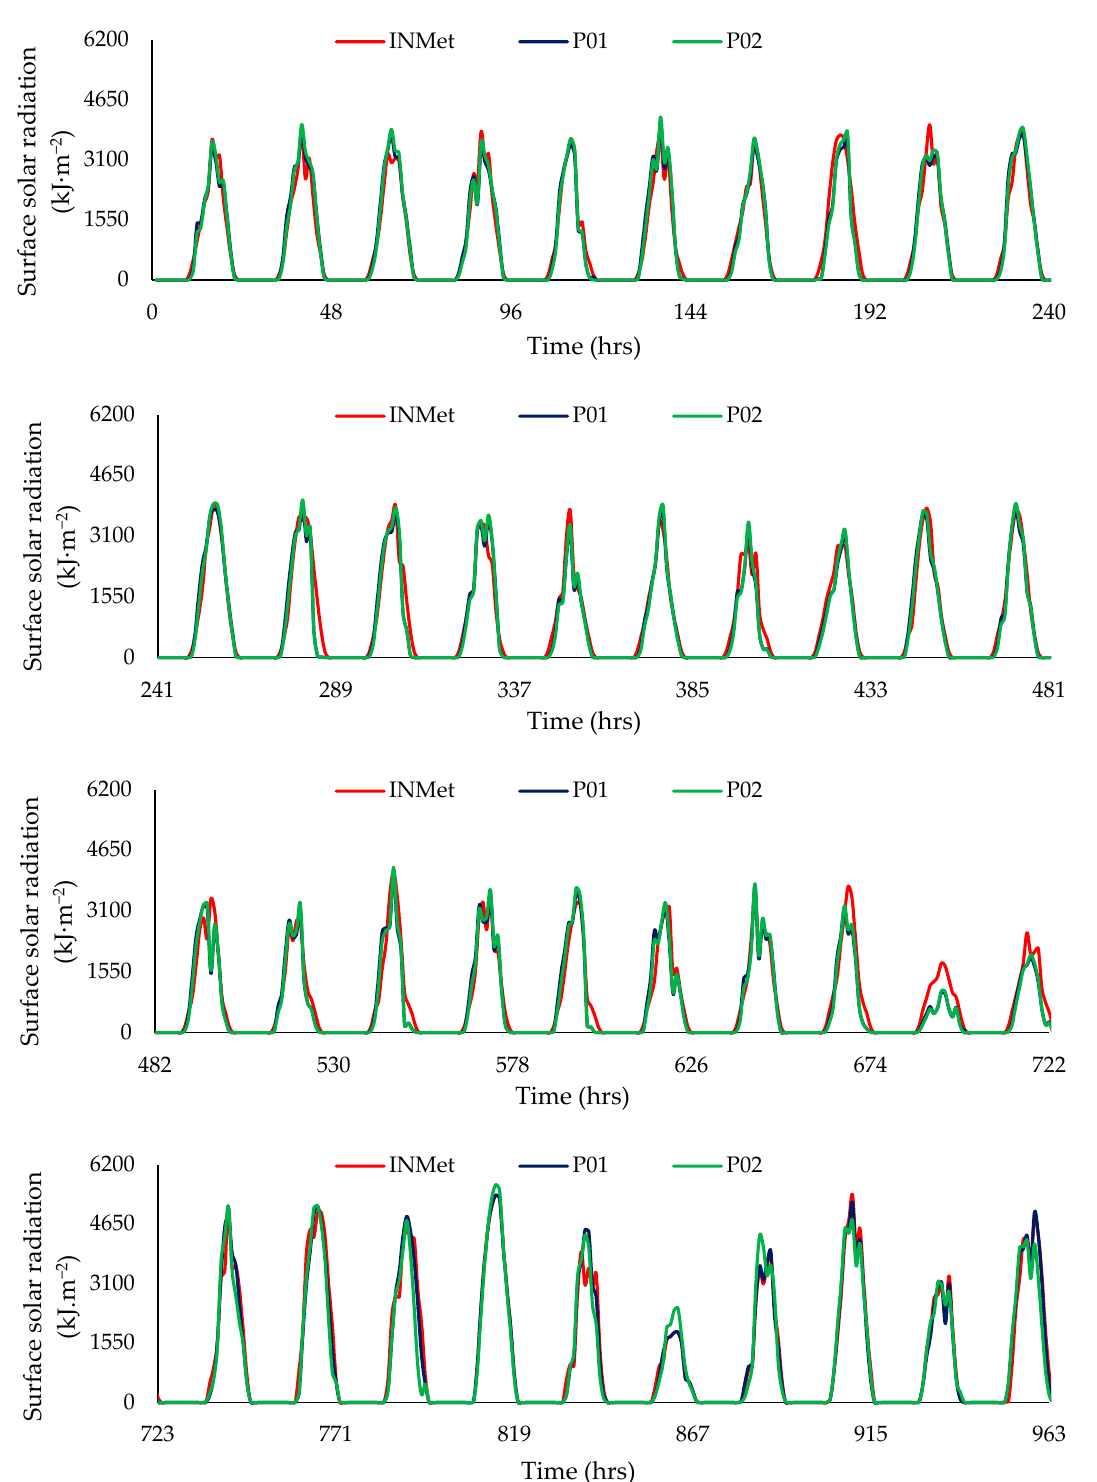
Figure 12. Comparison between the incoming surface solar radiation (INMet) and the responses of the prototypes (P01, P02) for Campina Grande, Brazil.